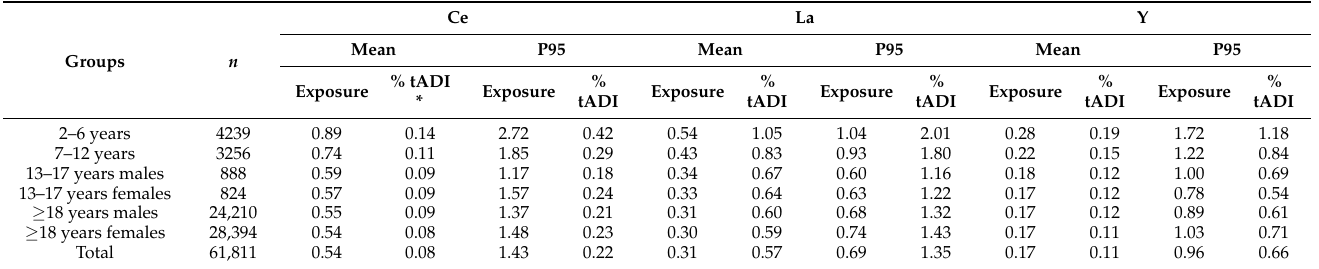
Table 3. Dietary mean and P95 exposure of Ce, La, and Y estimated in the general population and different sex–age groups of the Chinese population ( µ g/kg BW).